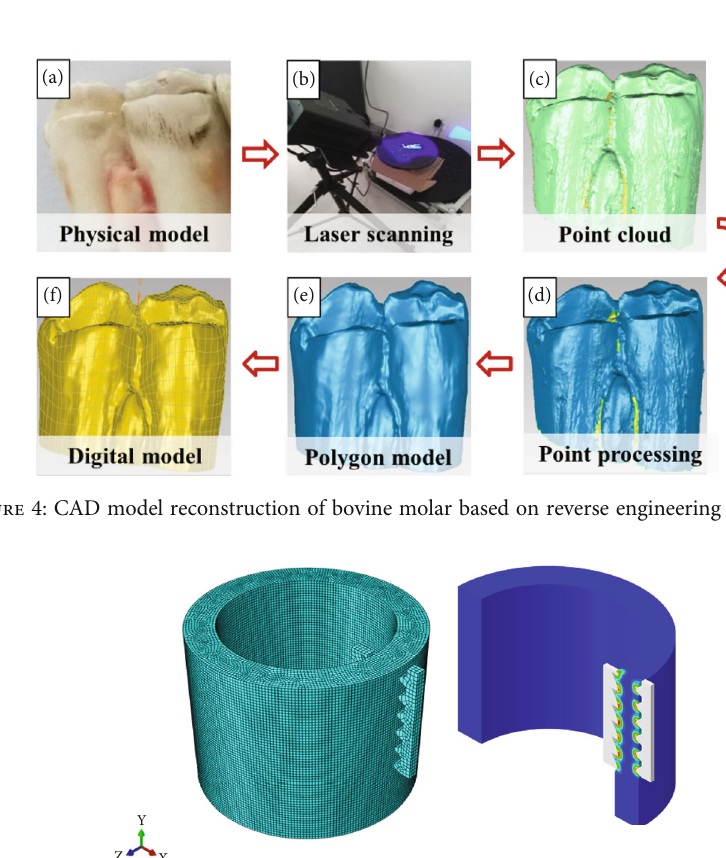
Figure 3: Typical occlusal mode of natural teeth: (a) human teeth; (b) bovine molars; (c) wolf teeth.